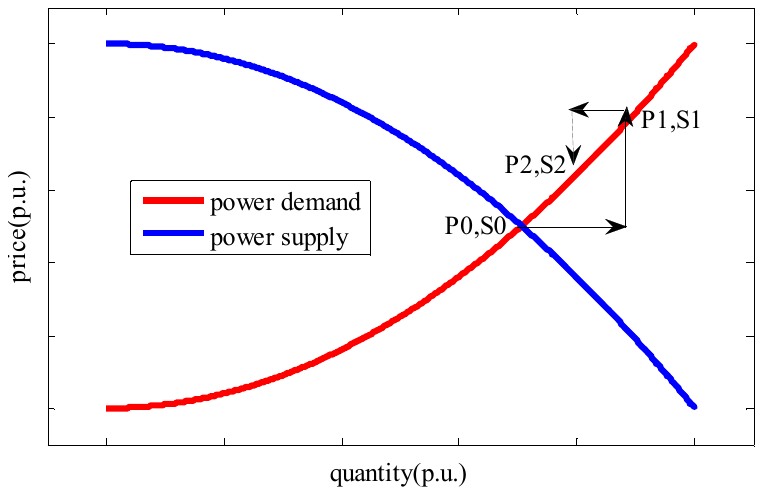
Figure 6. Psychological profile of an EV customer in a DRP